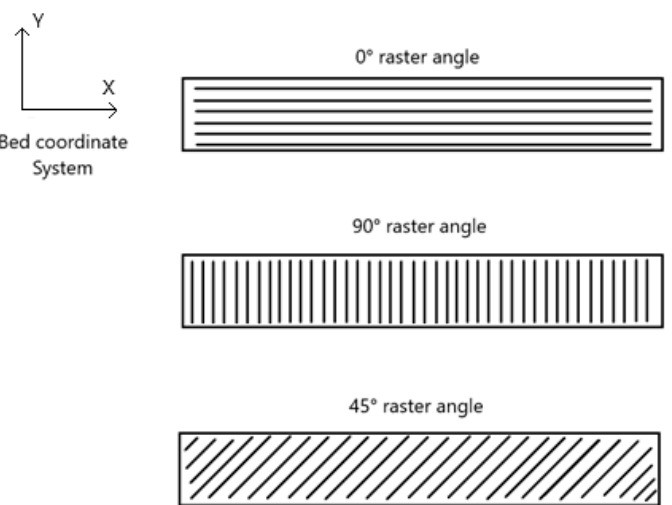
Figure 3. Raster angle representation with the help of flatwise samples.